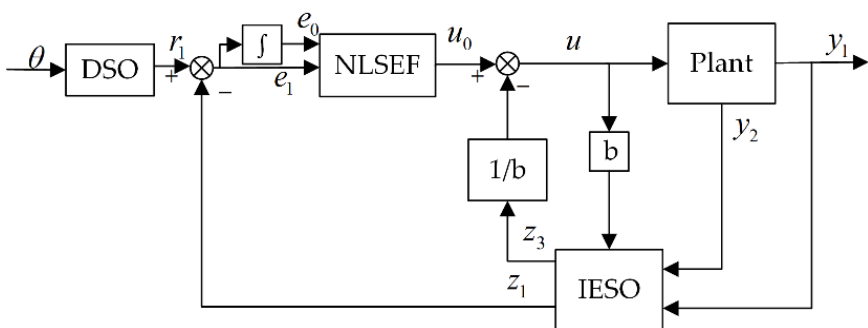
8 of 25 Figure 7. The overall block diagram of the control system. 2.3.1. The Principle of IADRC Compared to the conventional ADRC [22], the IADRC reduces the response time of the controller and effectively reduces the impact of the input signal on the system by de- signing the desired signal in advance and avoiding the use of a tracking differentiator [32]. The extended state observer (ESO) is improved by inputting the actual speed value into the observer so that the observed speed is closer to the actual speed and the disturbance